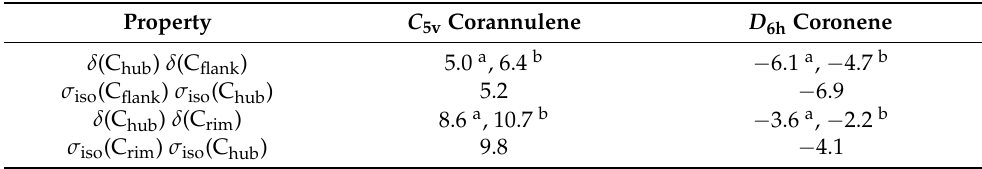
Table 2. Differences between 13 C chemical shifts ( δ ) from the literature and the isotropic shieldings obtained in this work for C 5v corannulene and D 6h coronene (in ppm). Property C 5v Corannulene D 6h Coronene δ (C hub ) δ (C flank ) 5.0 a , 6.4